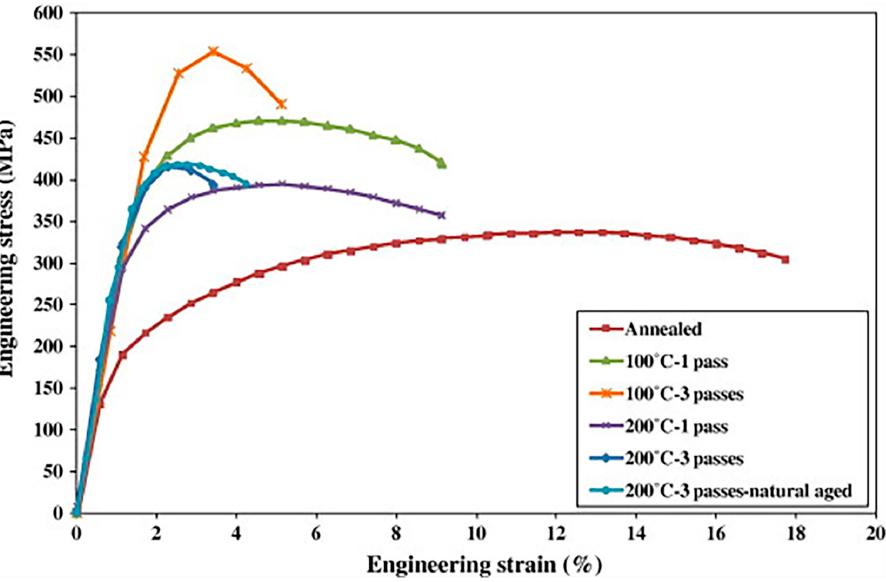
Figure 9. Tensile engineering stress–strain curves for initial and processed materials at room tem- perature